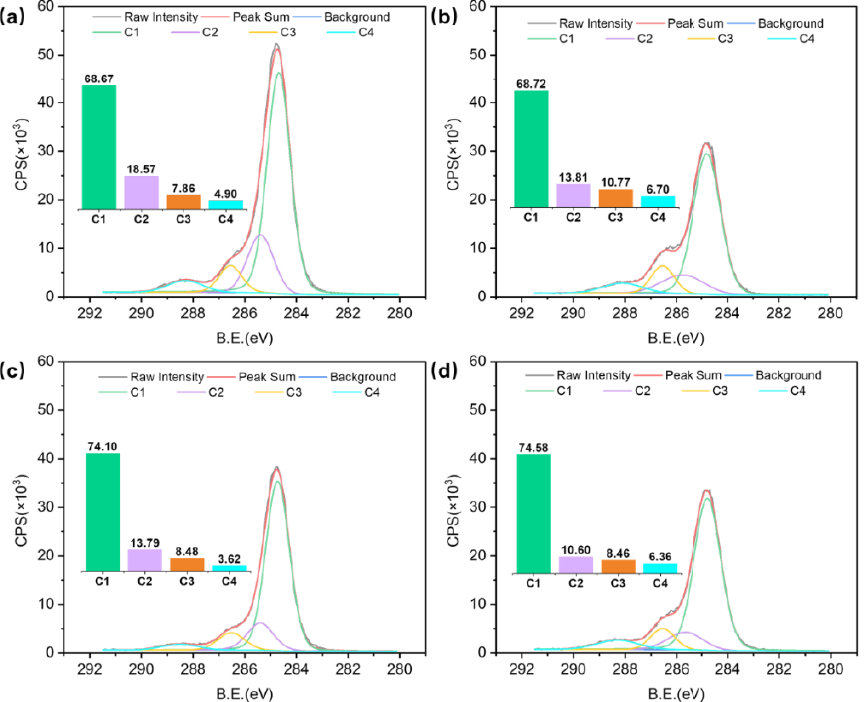
Figure 7. Effect of TPM duration on C1s’ peak components in the following samples: ( a ) 5 min; ( b ) 8 min; ( c ) 11 min; and ( d ) 14 min. The bars with different colors inside of the figure represent the values of C1, C2, C3, and C4, respectively.